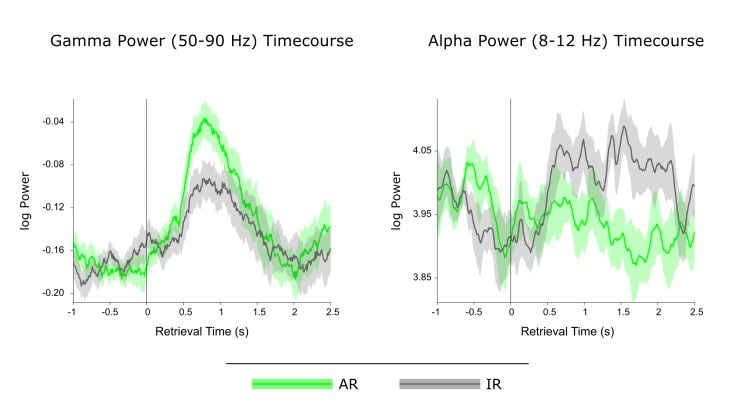
No condition differences in the baseline period.Gamma and alpha retrieval time courses (log transformed) are shown without baseline correcting the data, ensuring that condition differences are not driven by pre-stimulus baseline effects (see main text for statistics).